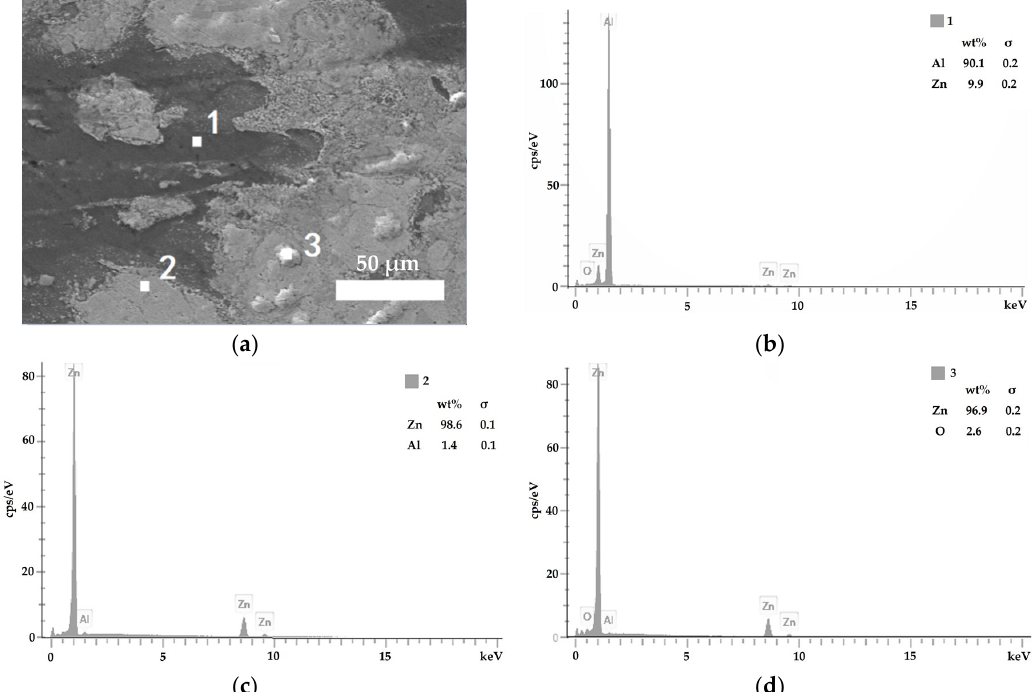
Figure 5. Energy dispersion point spectrum (EDSP) of the Zn 65 Al 15 Mg 5 ZnO 15 composite coatings amplified at 3000 × microstructure for the element analysis of three specimens: ( b ) Point 1, ( c ) Point 2, and ( d ) Point